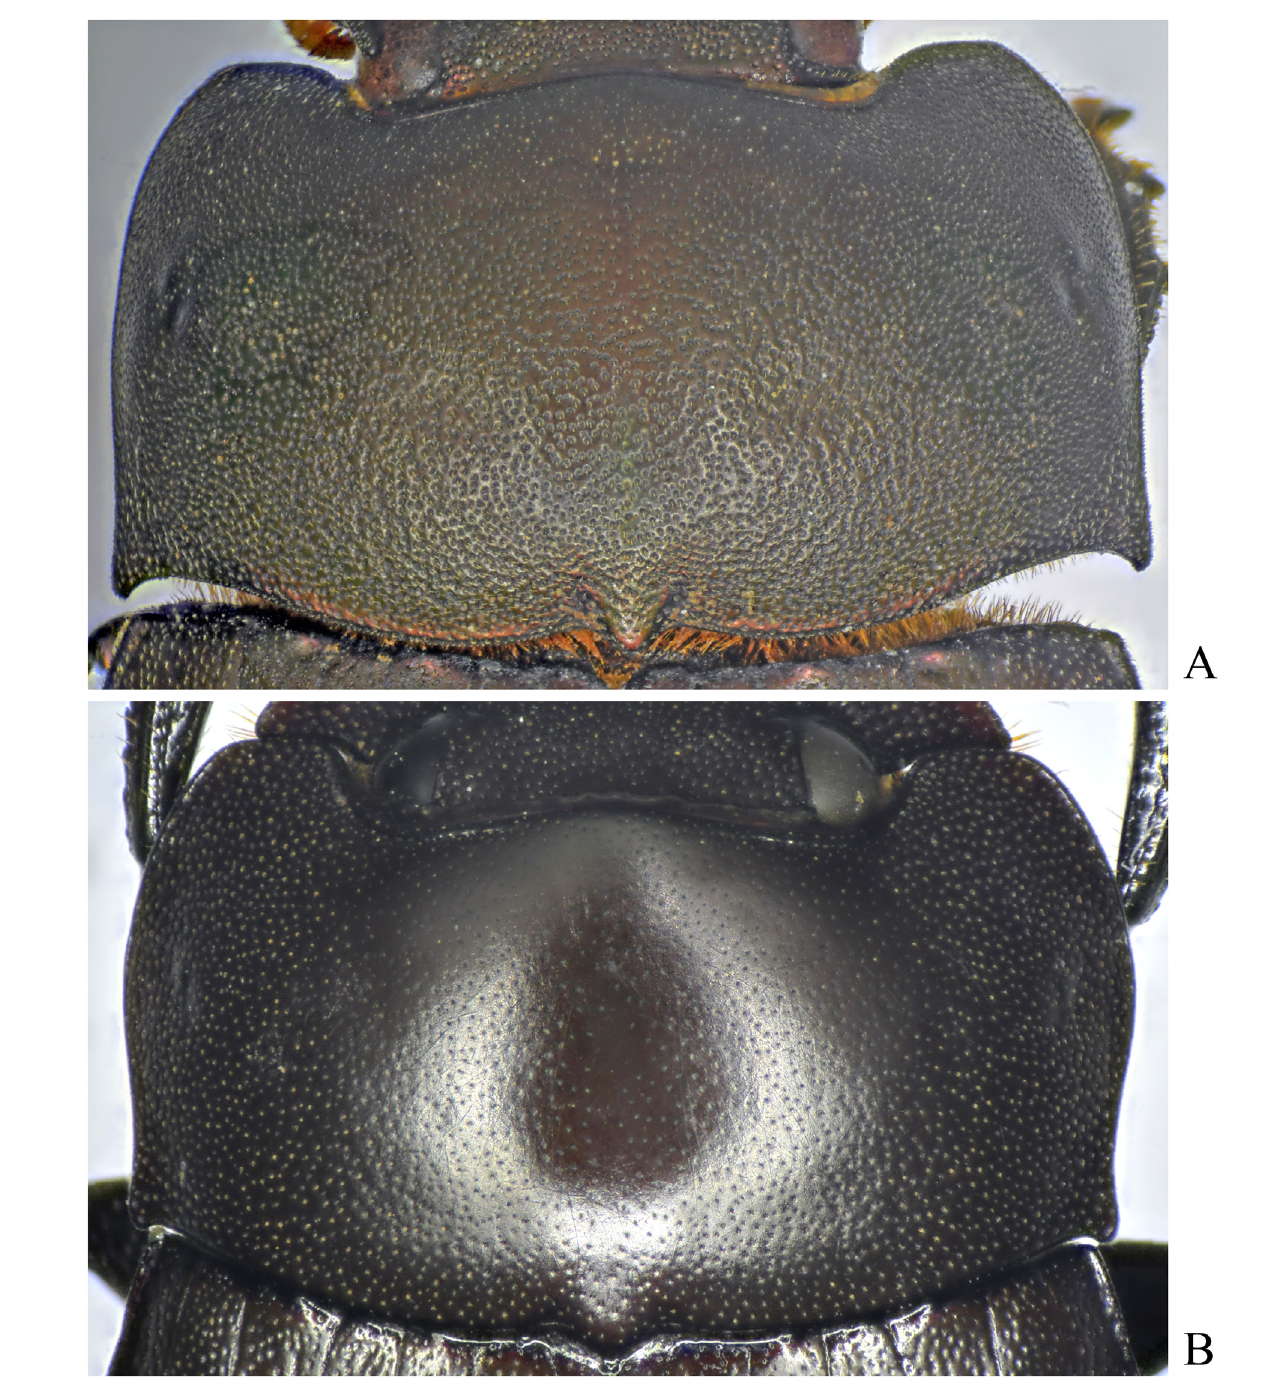
Fig. 12. Pronotum. A . Streblopus opatroides van Lansberge, 1874. B . S. punctatus (Balthasar, 1938). Note the differences in the umbilicate punctation and colour between the